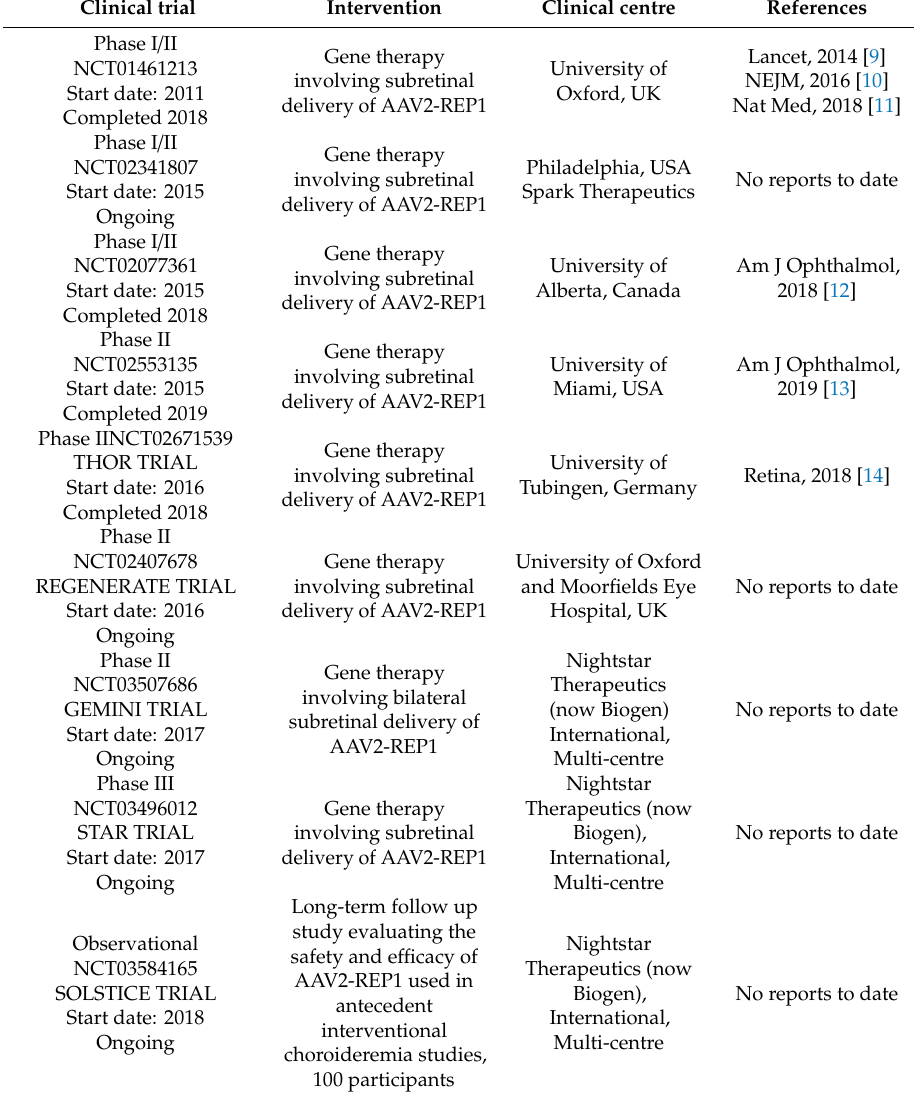
Table 1. Summary of interventional gene therapy clinical trials in